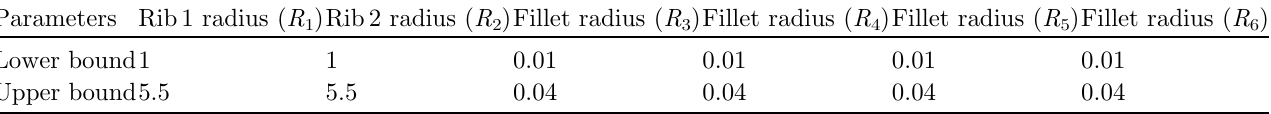
Table 1. Design variables range of values (in millimeters).